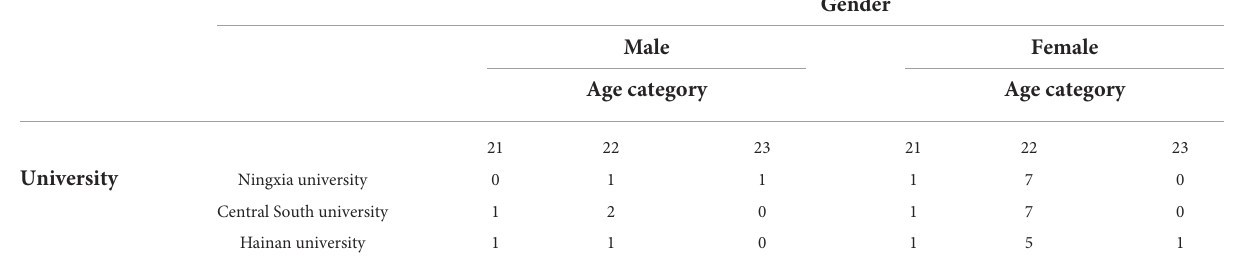
TABLE 2 Profile of the participants (quantitative).